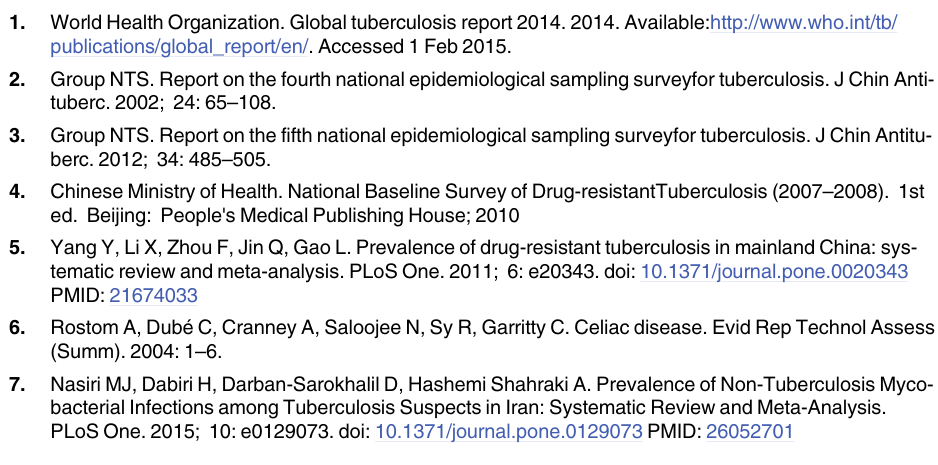
S1 Table. Quality assessment checklist for included articles. S2 Table. Included articles after full-text evaluation. S3 Table. Detailed data of the included studies. S4 Table. Distribution of different drug resistance patterns among new and retreatment cases in China. S5 Table. PRISMA 2009